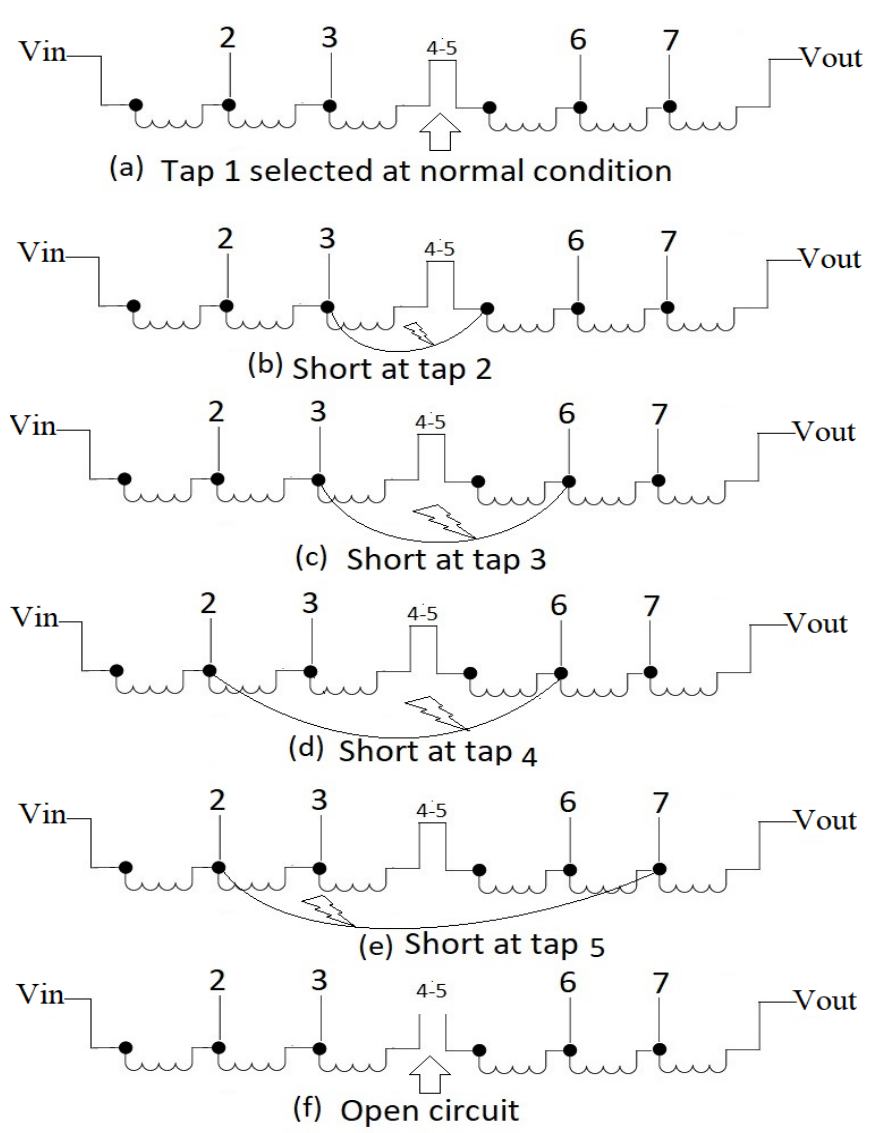
Figure 3. A schematic diagram for staging various SC and OC faults on the transformer winding.